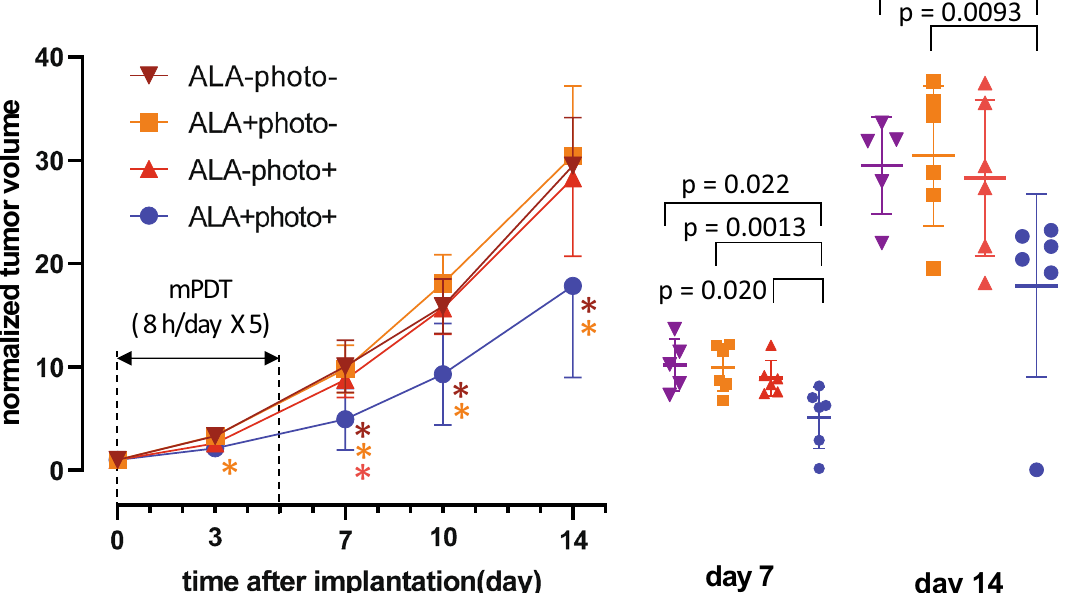
Figure 4. Tumor growth curve. Normalized tumor volume indicates the relative volume when the tumor volume at day 0 (at the start of mPDT) is set to 1. The mPDT was performed during the period shown in the graph. *; p < 0.05 compared to groups of animals shown in each color. The right side shows a volumetric scatter plot of individual tumors on day 7 and day